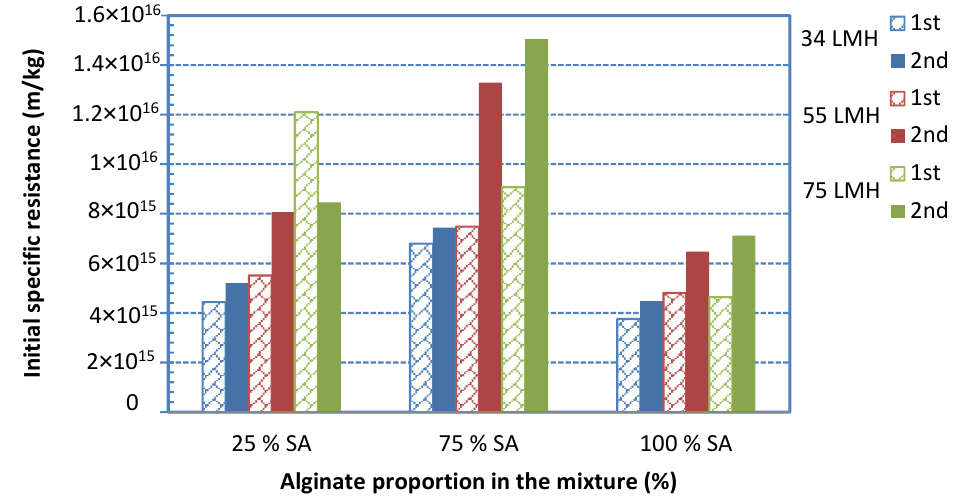
Figure 13. Initial fouling resistance α i values for various foulant compositions and fluxes, with feed-fluid prepared by different protocols: “1 st ” and “2 nd ” means main and alternate protocol, respectively.